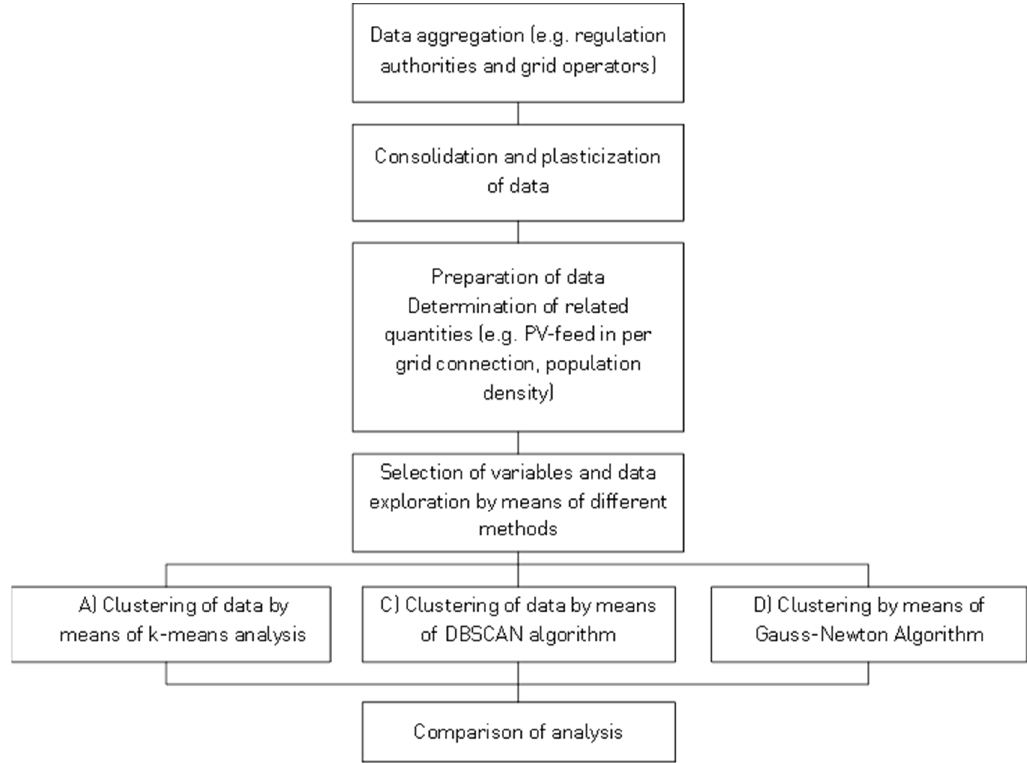
Figure 5. Block diagram of empirical method.